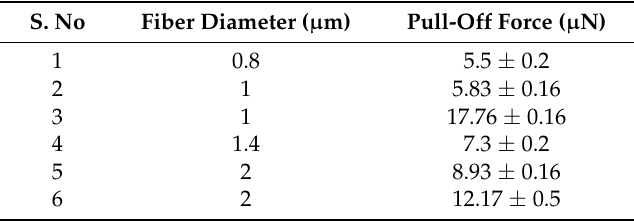
Table 1. Pull-off force measured for fibers with diameters ranging from 0.8 to 2 µ